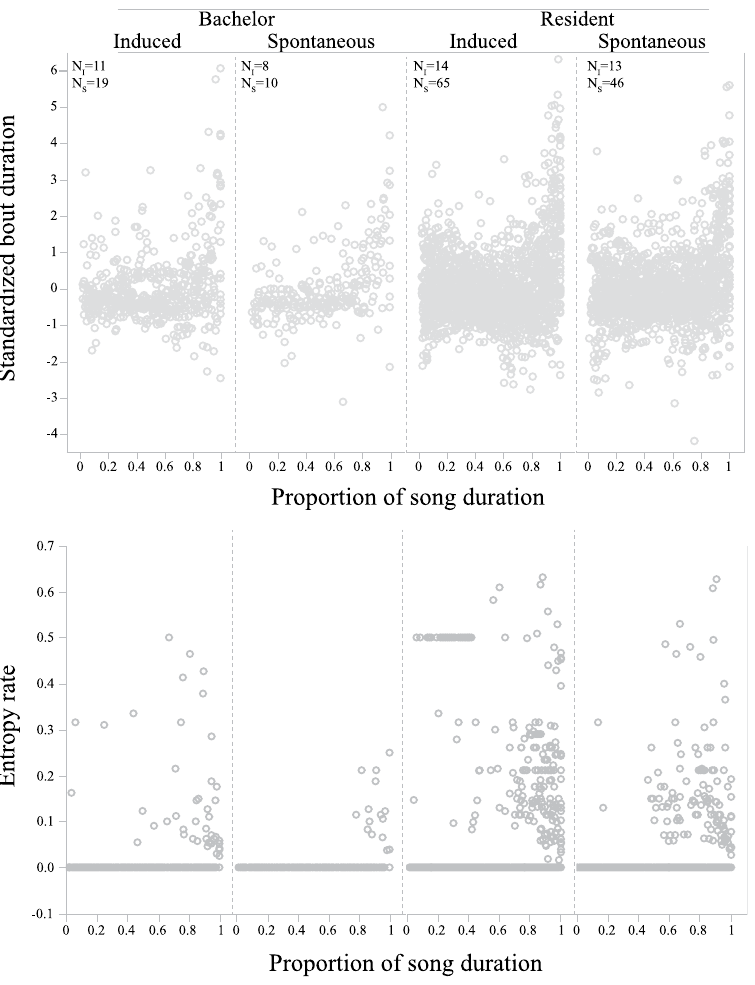
Figure 3. Progression plots of ( a ) standardised bout duration and ( b ) bout entropy rate and their proportional location through the signal. Bachelor songs were performed by males without stable association with a female group. Resident songs were performed by males that were regularly observed associating with a female group. Induced songs were performed following an external trigger event. Spontaneous songs were performed without any observable trigger. N i denotes number of individual males; N s denotes number of songs in a corresponding